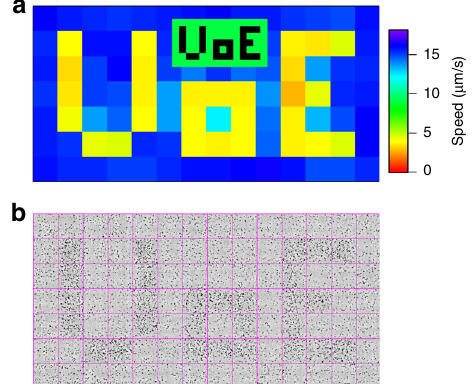
Fig. 1 Demonstration of spatial-resolved differential dynamic microscopy. Projecting light patterns onto a sample of light-powered E . coli AD10 (at OD = 1) leads to a spatial variation of the mean swimming speeds (cid:1) v . a Map of (cid:1) v as measured by sDDM when the negative ‘ UoE ’ pattern shown in inset is projected onto the sample. b Phase contrast image about 20 s after applying the pattern, showing accumulation in the darker regions. Magenta lines indicate the square tiles of 64 pixels (90 μ m) size used for the sDDM